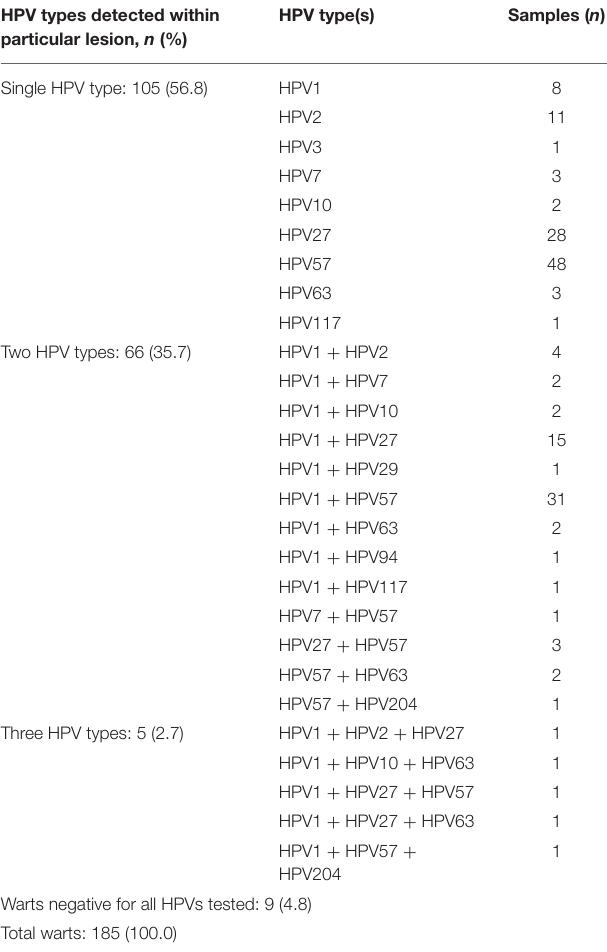
TABLE 1 | Distribution of human papillomavirus (HPV) types in 185 common warts with single and multiple HPV infections. HPV types detected within particular lesion, n